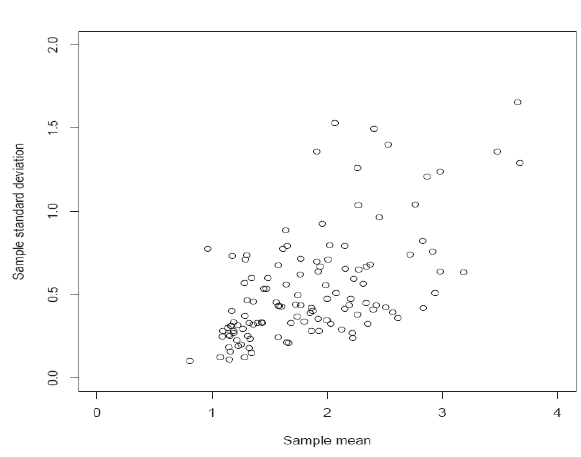
Figure 1 – Scatterplots of sample mean vs standard deviation for a sample of 130